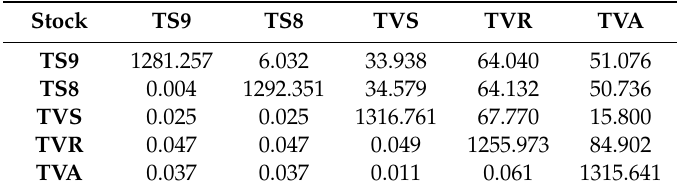
Table 3. Below diagonal: F ST values for pairwise comparisons of 5 sea trout stocks. All values were significant for a p = 0.05; on diagonal: average number of pairwise di ff erences within population; and above diagonal: Nei’s genetic distance D